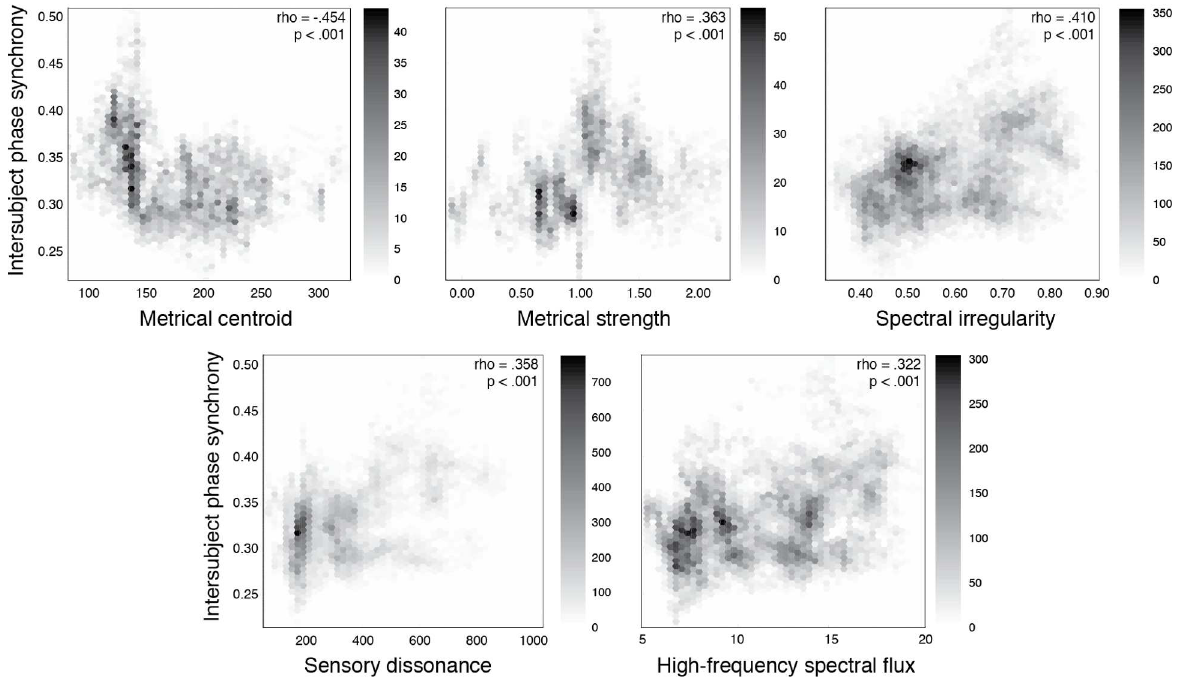
Fig 3. Relationship between group synchrony of movement and different features of the music. Values over the durationof the music set are plotted for intersubject phase synchronization and metrical centroid or speed of pulsations, metrical strength or clarity of pulsations, spectral irregularity or variability, sensory dissonance or roughness, and high-frequency spectral flux or